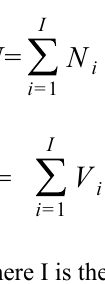
Grey seals in the North Atlantic and the